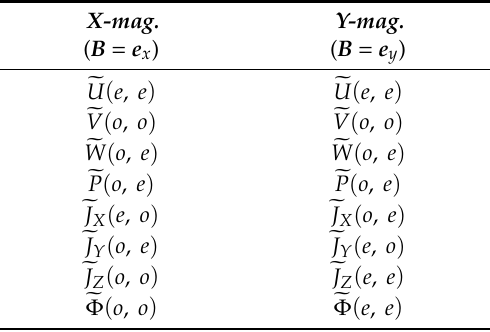
Table 4. The computational results obtained for the symmetry modes for the X -directional magnetic field and the Y -directional magnetic field. The notation is such that, e.g., ( o , e ) stands for an odd function in x -direction and an even function in y -direction. X-mag. Y-mag. ( B = e x ) ( B = e y